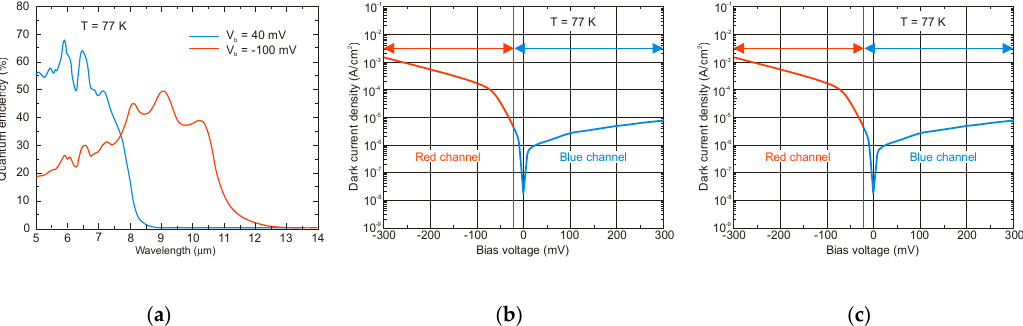
Figure 70. Performance characteristics of bias-selectable dual-band nBn InAs/InAsSb SL detector at 77 K: ( a ) spectral QE in FSI configuration without any anti-reflection coating for two applied bias: + 40 mV (blue channel) and − 100 mV (red channel), ( b ) dark current density versus voltage for blue and red channels, ( c ) D* of the blue and red channels at +40 and − 100 mV voltage (after [168]).